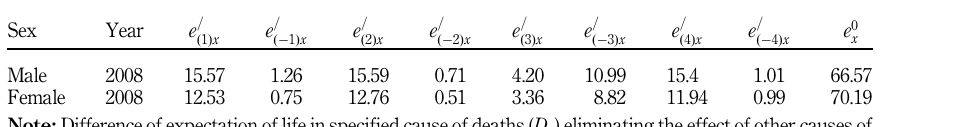
Figure 2. Expectation of life in specified causes of deaths ( D α ) eliminating the effect of a single cause